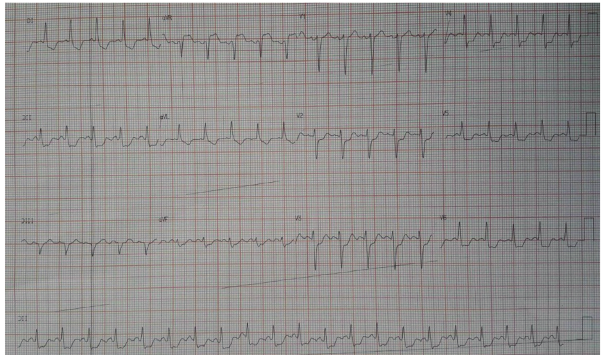
Figure 2: ECG findings: the resting 12 leads electrocardiogram showing the ST segment elevation in the lead aVR with marked diffuse ST segment depression.